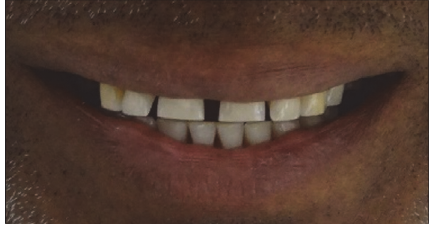
Figure 3: Preoperative extraoral view of the